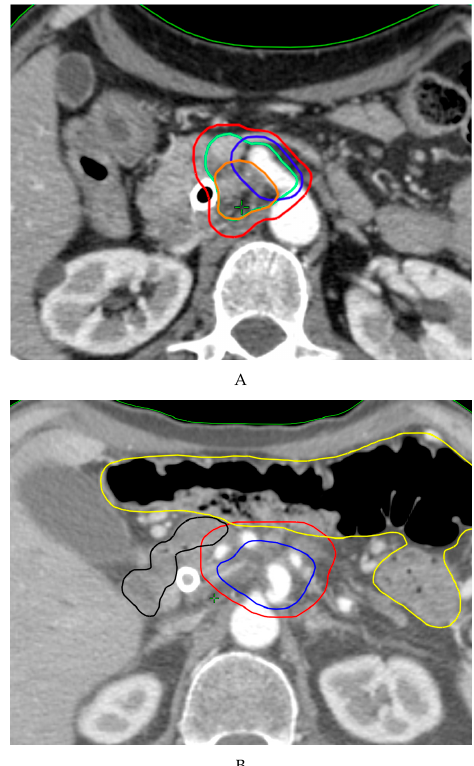
Figure 1. The Simultaneous Integrated Boost (SIB) approach for pancreatic cancer in neoadjuvant ( A ) and definitive ( B ) setting. In BRPC ( A ), the SIB target volume could be directed to the tumor-vessel interface (TVI). PTV tumor = red; PTV high dose (SIB TVI) = blue; CTV = green [GTV (orange) + TVI]. In unresectable LAPC ( B ), the hypoxic center inside the pancreatic tumor could be defined as boost volume. PTV tumor = red; PTV high dose = blue; duodenum = black; bowel = yellow. Cancers 2020 , 12 , 1729